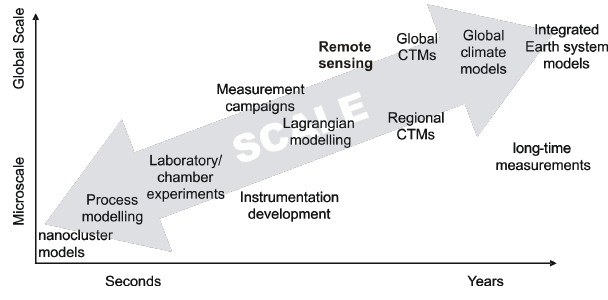
Fig. 1. The “EUCAARI arrow” or research chain connecting molecular scale processes with the global scale through integrated measurements, modeling and theory (Kulmala et al.,